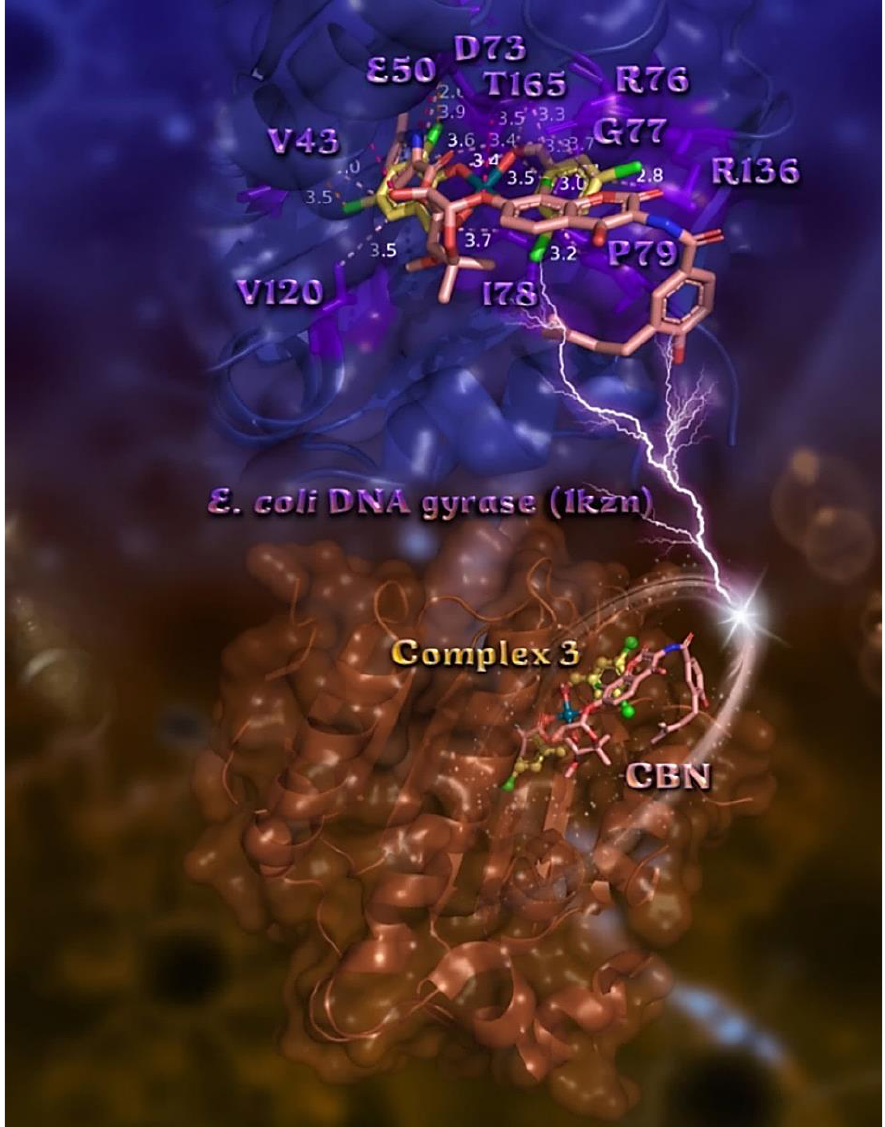
Figure 8. ( Lower panel ) Docking pose orientation of best (lowest Δ G bind energy) bound complex 3 (rendered in a ball-and-stick mode for lower panel and stick in the upper panel, and colored according to atom type in yellow-orange C atoms) superimposed with the co-crystallized drug CBN (salmon C atoms rendered in stick representation) in the crystal structure of E. coli DNA-gyrase (PDB ID: 1kzn). The target protein is illustrated as a cartoon colored in brown with depth cue in the ray-tracing rendering of the whole structure with an additional depiction of semi-transparent surface colored according to the cartoon. ( Upper panel ) A close-up view of the ATP-binding site architecture of the best (lower energy ranking) binding pose of 3 superimposed with CBN. The target protein is illustrated as both semi-transparent cartoon and surface colored in deep blue. Selected critical contacting amino acid residues of the binding pocket are rendered in a stick model and colored in purple-blue. Binding contacts of 3 are shown as yellow dotted lines. Heteroatom color-code: O: red, N: blue, Cl: chartreuse green, and Pd: deep teal. Hydrogen atoms are omitted from all molecules for sake of clarity. The final structure was ray-traced and illustrated with the aid of PyMol Molecular Graphics Systems. Binding interactions are shown in Table S3.